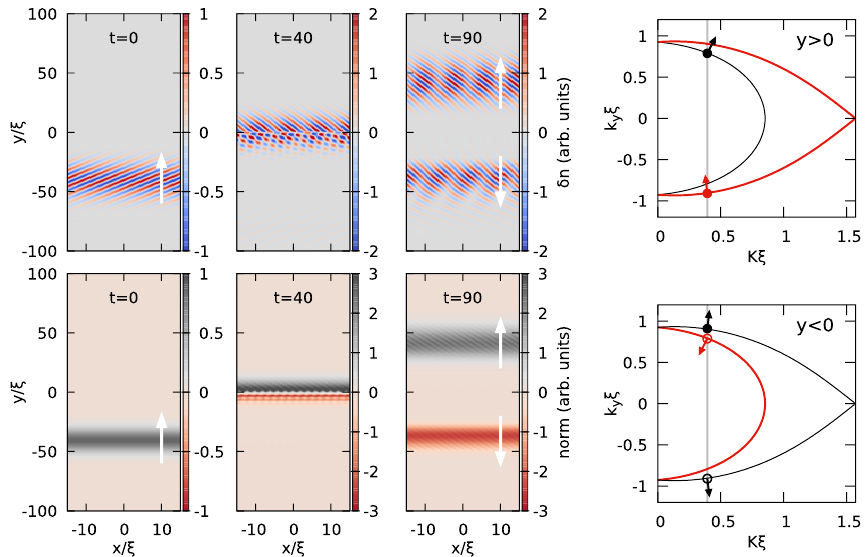
Figure 9: Same calculation as in Figure 8 for the same ∆ v = 3.14 c a different value of the conserved Bloch wavenumber K . For this choice, additional modes enter into play. The result is a superradiant process in which the incident positive-norm packet is amplified in transmission, while a negative-norm packet is reflected. The presence of the additional modes is signalled by the weak oblique fringes that are visible on top of the wavepackets in the lower panel for t = 90 ħ h /µ